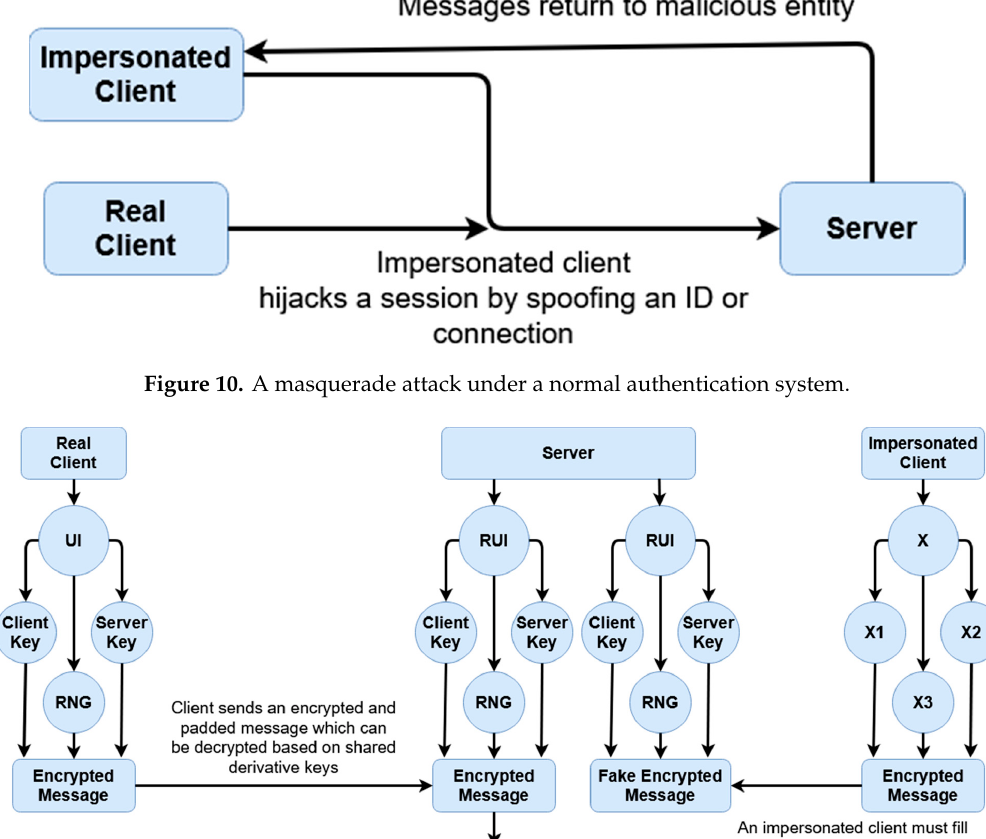
Figure 11. A masquerade attack under TFHVA scheme.